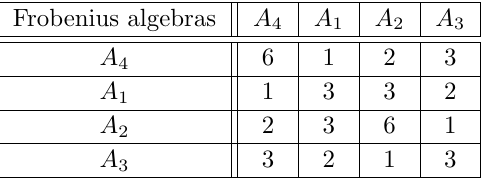
Table 7 . The GSDs of the extended LW model with Rep speci(cid:12)ed by two not necessarily di(cid:11)erent Frobenius algebra objects of Rep